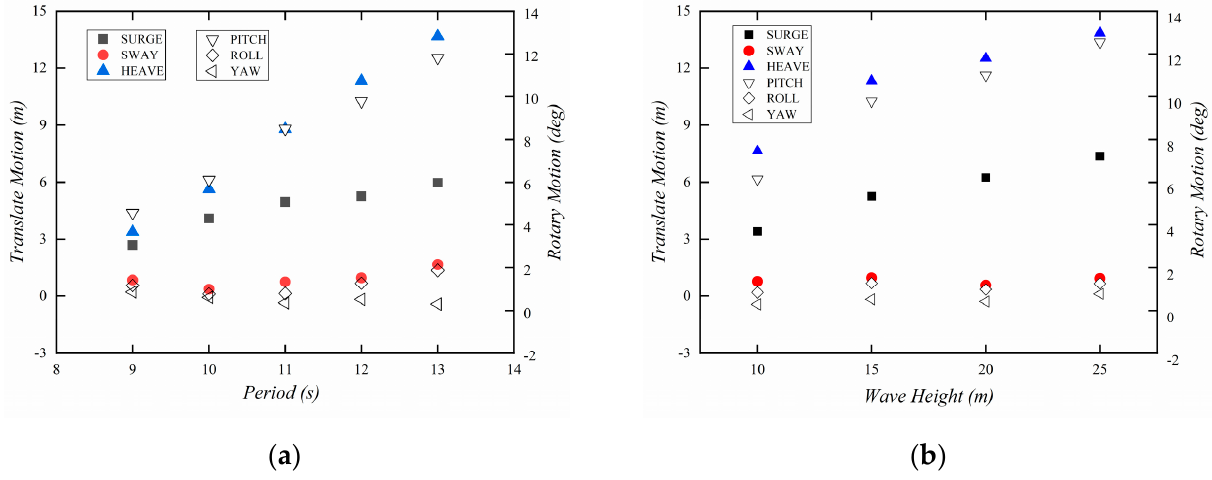
Figure 14. The maximum amplitude of the six-degree-of-freedom motion of the platform in the basin test under regular wave conditions. ( a ) β = 180°, T = 9 − 13 s, and H = 15 m; ( b ) β = 180°, T = 12 s, and H = 10~25 m.